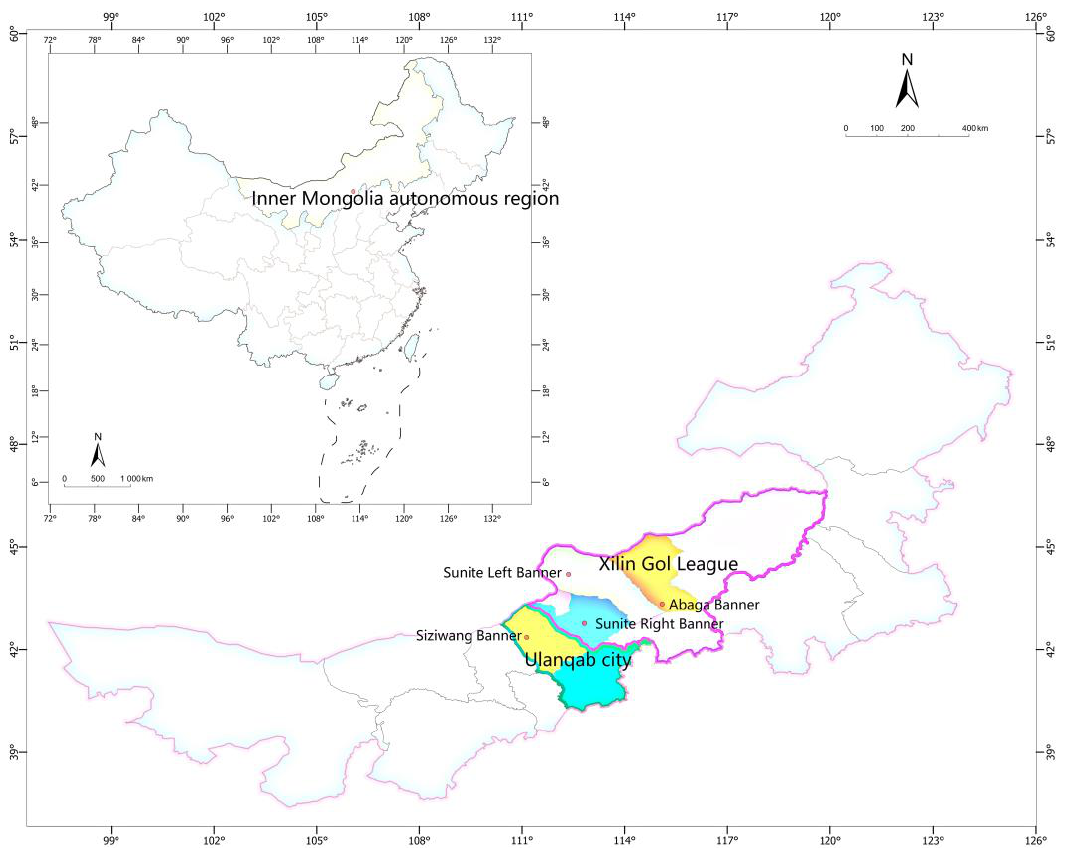
Figure 2. Regional location information for the lamb samples.